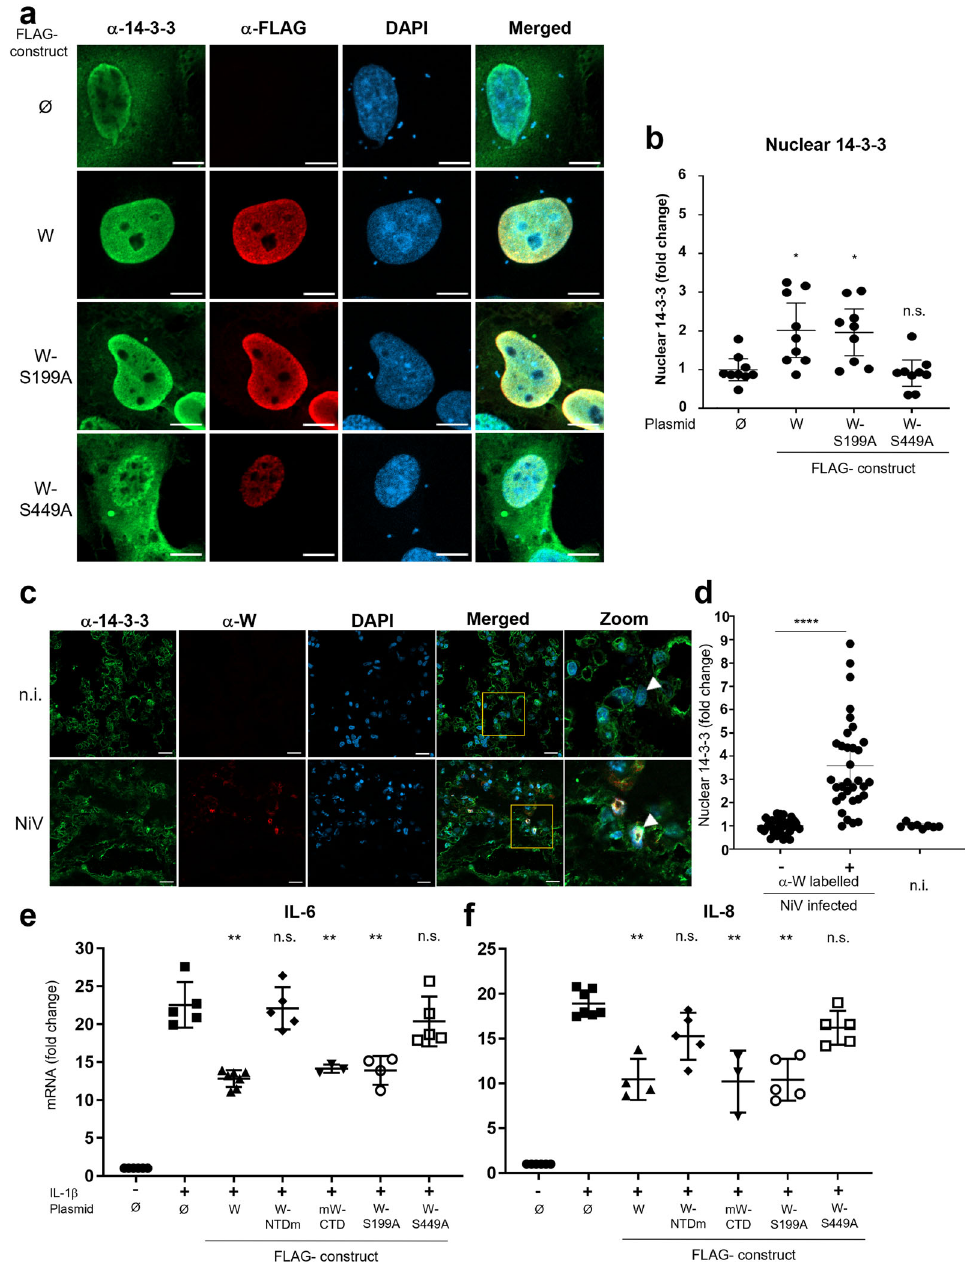
Fig. 6 W protein induces 14-3-3 nuclear accumulation in transfected and in NiV-infected cells, and suppresses the production of proin fl ammatory cytokines in vitro. a HPMECs were transfected with plasmids encoding FLAG-tagged W protein variants. Twenty hours later, cells were stimulated with 10 ng/mL of IL-1 β for 20 min, fi xed, permeabilized, stained with DAPI and anti-FLAG and anti-14-3-3 antibodies before analysis by confocal microscopy (scale bar = 10 µ m). b Mean fl uorescence intensity for 14-3-3 protein was measured in a IL-1 β stimulated cell nucleus. Signal obtained from anti-W-labeled cells was normalized to the signal from unlabeled cells and expressed in terms of fold change. Error bars represent the con fi dence interval of the mean (CI 95%) for nine cells, combined from two independent experiments. Statistical signi fi cance was assessed by a one-way unpaired ANOVA completed with a multiple-comparisons Tukey ’ s test; * p < 0.05. c Nuclear accumulation of 14-3-3 in NiV antigen-positive cells from lungs of in vivo-infected AGM with a representative image including an enlarged portion of the merged images. A NiV-infected AGM was killed 10 days post infection and lung sections were labeled using DAPI, anti-W-CTD (red), and pan 14-3-3-speci fi c rabbit polyclonal antibodies (scale bars = 20 µ m). d Mean nuclear signal of 14-3-3 in infected cells as labeled with anti-W-CTD antibodies, expressed as the fold change of nuclear signal in non-infected cells as lacking W-CTD labeling within the same fi eld. Error bars represent the con fi dence interval of the mean (CI 95%) from fi ve different lung sections. Statistical signi fi cance was assessed by paired t -test between unlabeled and anti-W-CTD-labeled cells from NiV-infected slices (**** p < 0.0001). Mean nuclear 14-3-3 signal in the nucleus of lung cells from a non-infected AGM (n.i.) was comparable to that observed in non-infected cells (i.e., lacking anti-W-CTD labeling) from NiV-infected AGM. e , f HPMECs were transfected with plasmids encoding FLAG-tagged W protein variants and stimulated 20 h later with 10 ng/mL of IL-1 β for 4 h. Cells were lysed 24 h later and quanti fi ed for their contents in IL-6 and IL-8 mRNA by RT-qPCR. Data columns represent mean values ± SD of at least three independent experiments with each point done in triplicate (** p < 0.01 using ordinary one-way ANOVA followed by a Turkey ’ s multiple comparisons